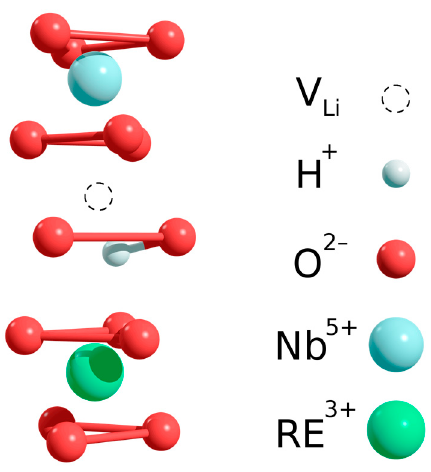
Figure 5. Schematic drawing of the RE 3+ Nb -OH − defect complex: the rare-earth ion substitutes niobium, the proton is bound to an oxygen shared by two octahedra “containing”, in turn, a structural and a Li + vacancy; the O-H bond is directed along a bisector plane of the oxygen triangle and tilted by about 6-8 degrees out of the oxygen plane towards the structural vacancy.